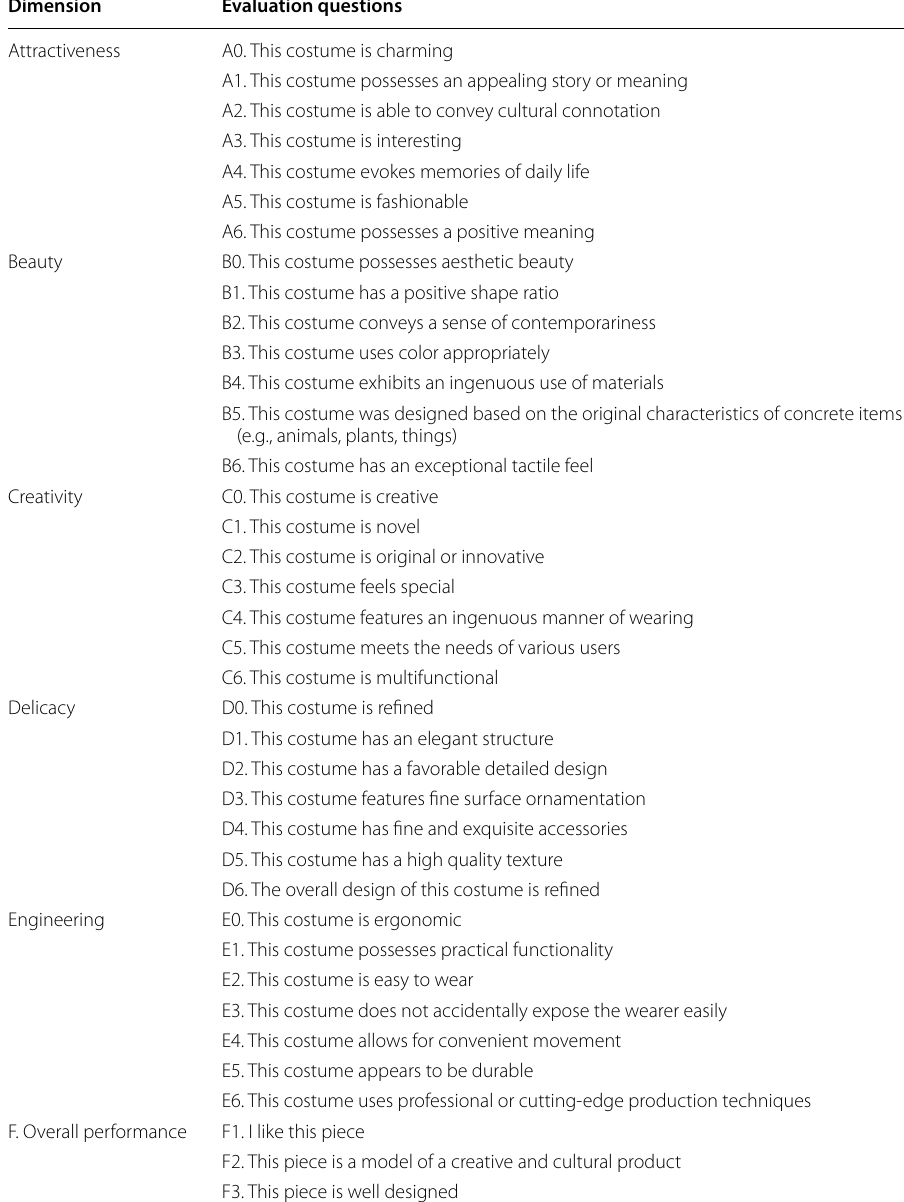
Table 2 Quantitative scale and evaluation of the incorporation of cultural elements into fashion